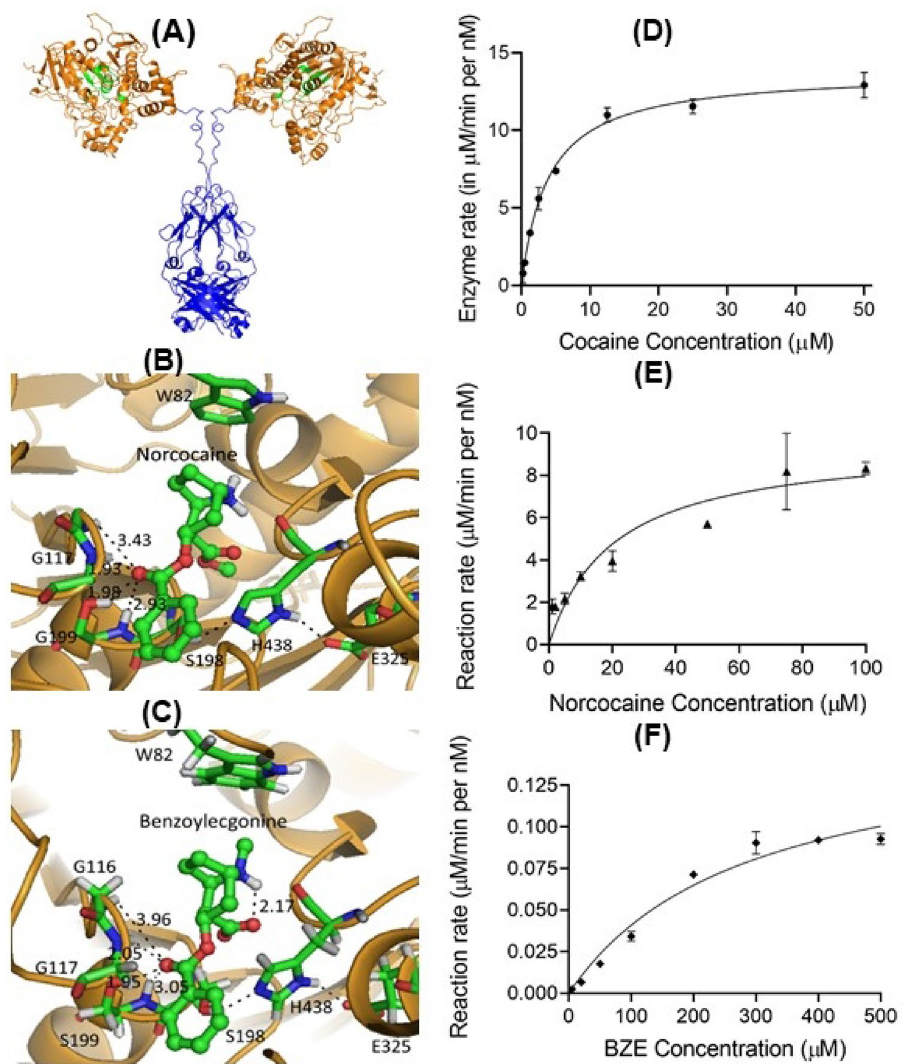
Figure 2. CocH5-substrate (norcocaine or benzoylecgonine) binding and the Michaelis–Menten kinetics. ( A ) The general shape of the CocH5-Fc(M6) fusion protein dimer in which the binding sites of CocH5 (the A199S/ F227A/P285A/S287G/A328W/Y332G mutant of human BChE) are highlighted. The CocH5 portion was based on the X-ray crystal structure of BChE (pdb identification code: 1P0P), and the Fc(M6) portion was based on the X-ray crystal structure of Fc (pdb identification code: 4N0U). ( B ) CocH5-norcocaine binding mode. ( C ) CocH5-benzoylecgonine binding mode. ( D ) CocH5-catalyzed hydrolysis of (-)-cocaine (data from previous report 9 ). ( E ) CocH5-catalyzed hydrolysis of norcocaine. ( F ) CocH5-catalyzed hydrolysis of benzoylecgonine. All measurements were performed in triplicate.